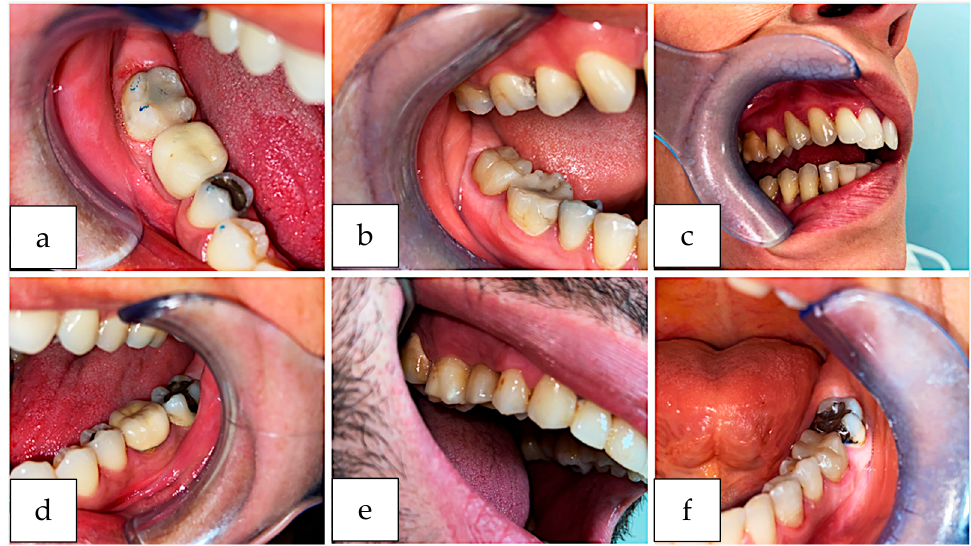
Figure 8. ( a ) Slight color mismatch on 46 crown; ( b ) Monolithic Zirconia single crown on 47; ( c ) Mono- lithic Zirconia single crown on 24; ( d ) Monolithic Zirconia single crown on 36; ( e ) Monolithic Zirconia single crown on 15; ( f ) Monolithic Zirconia single crown on